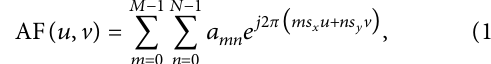
Figure 1: Diagram of the error reduction algorithm [22–24] and IFT method [25–35] as applied to planar phased antenna array